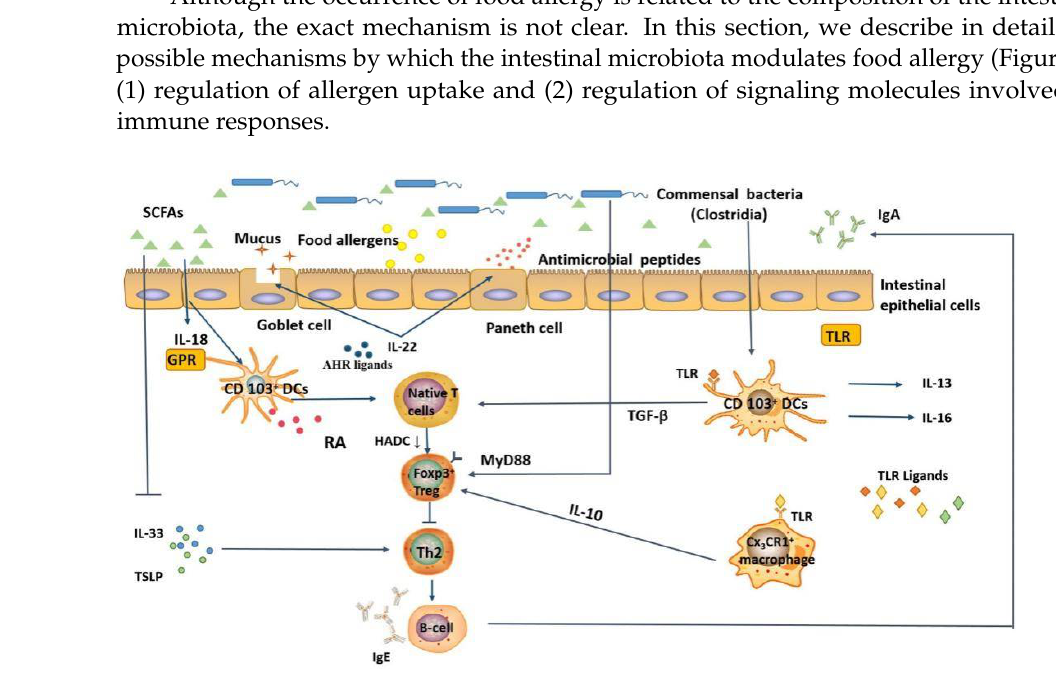
Figure 2. Potential mechanisms of intestinal microbiota and its metabolites in regulating food allergy, (1) regulation of allergen uptake and (2) regulation of signaling molecules involved in im- mune responses. Under normal circumstances, strengthening the intestinal mucosal barrier driven by commensal bacteria can reduce the entry of food allergens into the systemic circulation, thereby alleviating the symptoms of food allergy. When the balance between sensitization and oral tolerance is disrupted, signals (such as TLR, AHR) can be received by intestinal epithelial cells and DCs, en- hancing the epithelial barrier, promoting Foxp3+ Treg cell induction, and preventing the generation of food-specific Th2 effector populations. SCFAs, short-chain fatty acids; TLR, toll-like receptor; GPR, G-protein coupled receptor; HDAC, histone deacetylase; AHR, aryl hydrocarbon receptor.